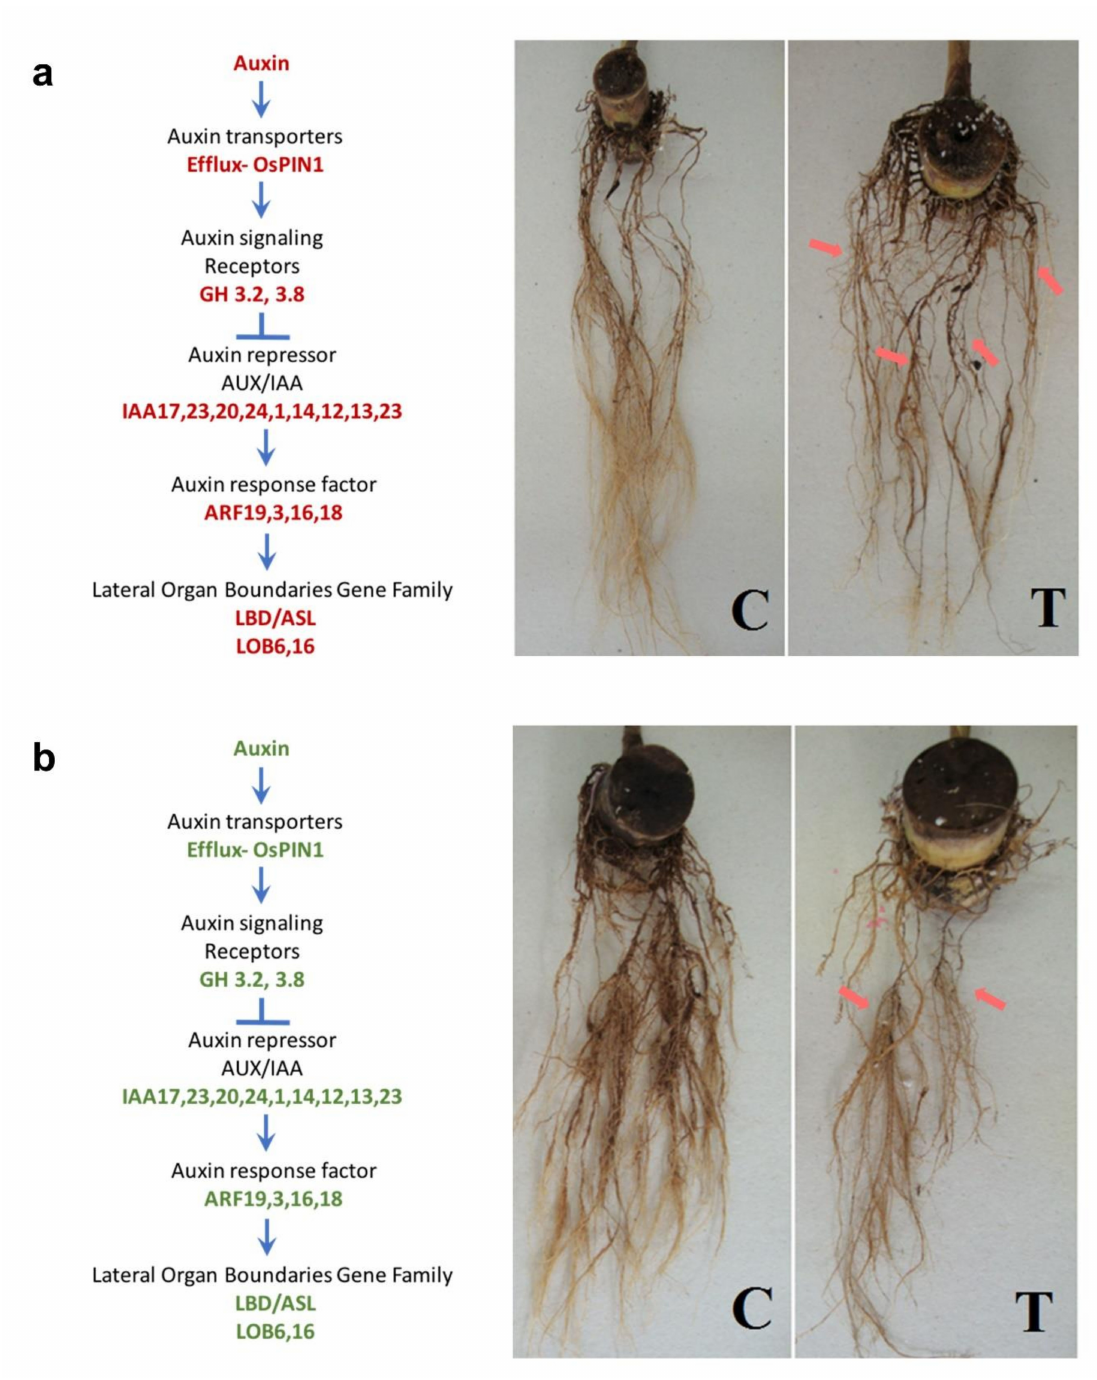
Figure 8. Auxin signaling pathway in sugarcane roots. Auxin transporters: OsPIN1—PIN-Formed auxin carrier component, GH3—indole-3-acetic acid amino synthetase, ARF—auxin response factor, LBD / ASL—lateral organ boundaries domain / asymmetric leaves2-like, LOB—lateral organ boundaries. The red and green colors indicate the upregulation and downregulation of the gene, respectively. The red arrows indicate the increased lateral root formation. ( a ) TAS—tolerant to aluminum stress, ( b ) SAS—sensitive to aluminum stress. C = control; T =